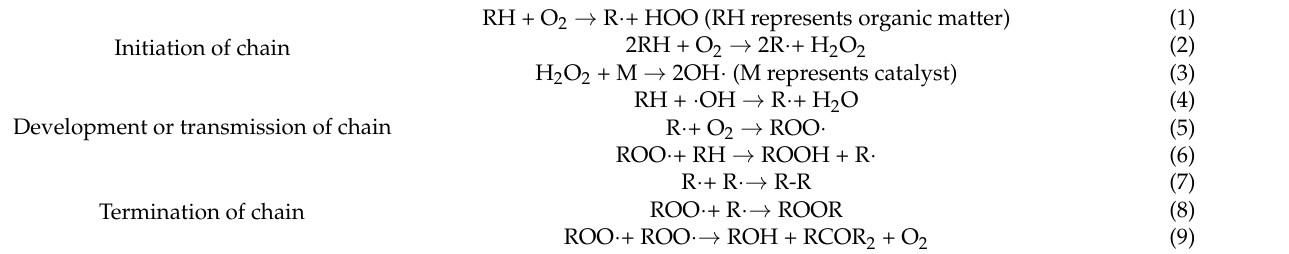
Table 1. The reaction process of